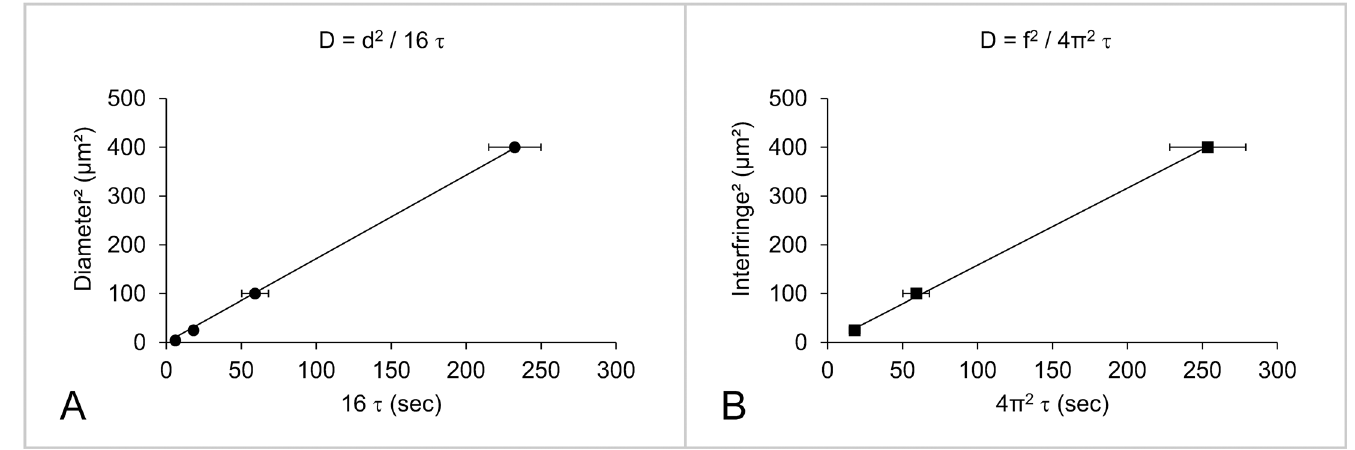
Fig 3. Diffusion coefficient (D) of DOPE-Rho lipids in the outer leaflet of a supported DOPC lipid bilayer deduced by varying the area of the bleached region (disks of diameters d = 2, 5, 10 or 20 μ m in A; networks of fringes with an interfringe f = 5, 10 or 20 μ m in B). The linear relationship between the bleaching area s 2 (d 2 or f 2 ) and the recovery time ( τ ) proves that lipid diffusion is controlled by Brownian motion. The diffusion coefficient (D) is calculated from the slope of this straight line: D = d 2 / 16 τ in the case of the disk system, and D = f 2 / 4 π 2 τ in the case of the fringe system. Each data point in A or B is the average of N = 3 independent bleaching experiments on different regions of the same bilayer, and the error bars correspond to the standard deviations from these averages. These experiments were reproduced with 4 independent (freshly prepared) bilayers using either the disk- or the fringe-shaped bleaching geometry, leading to D = (1.9 ± 0.3) μ m 2 /s.